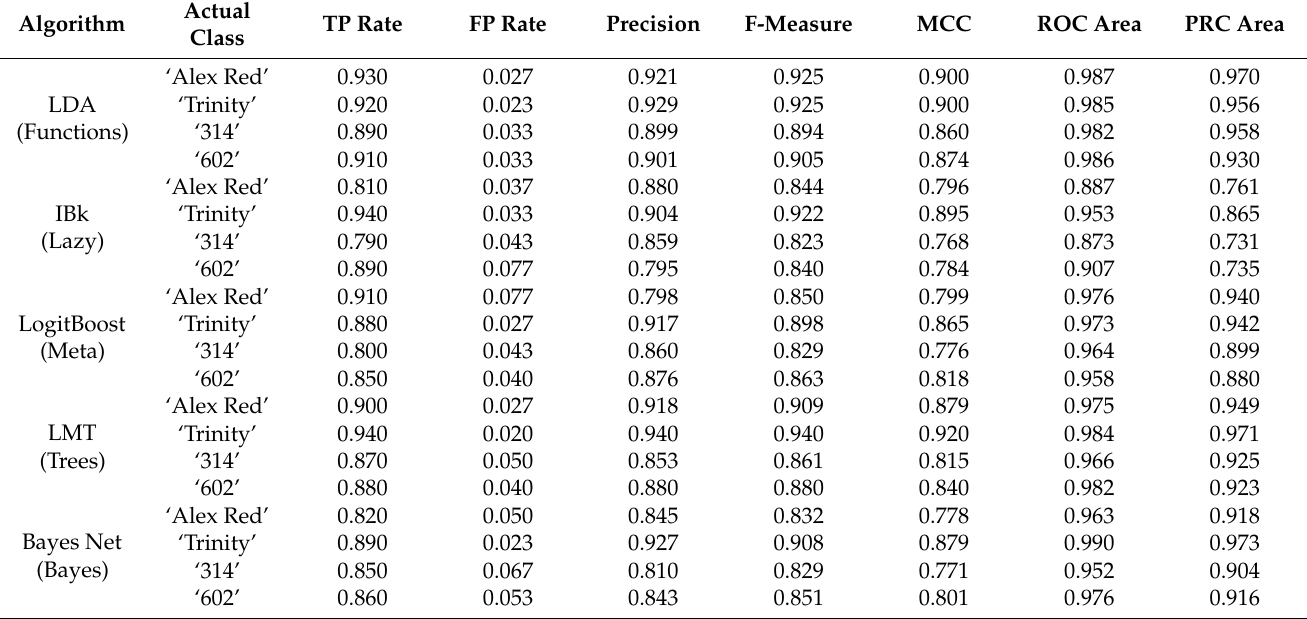
Table 5. The performance metrics of the classification of freeze-dried red-fleshed apple slices based on features selected from a set of image textures and color